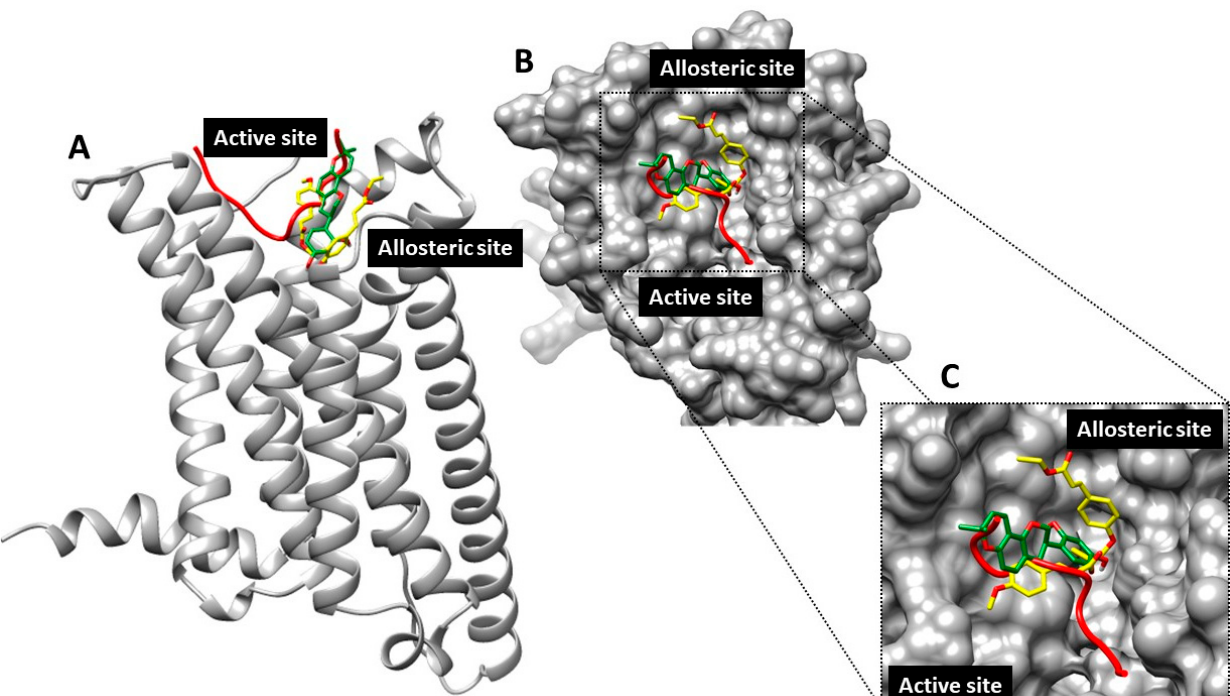
Figure 9. Proposed molecular interplay between α -MSH (red), glabridin (green), ethyl- p -methox- ycinnamate (yellow), and zebra fi sh MC1R (gray). ( A ) A side view of zebra fi sh MC1R presented in a ribbon form and ligands. ( B ) Birdseye view of zebra fi sh MC1R presented in a surface form and ( C ) a close-up view of a binding site of α -MSH (red), glabridin (green), ethyl p -methoxycinnamate (yel- low) on zebra fi sh MC1R(cid:31)s active and allosteric sites.